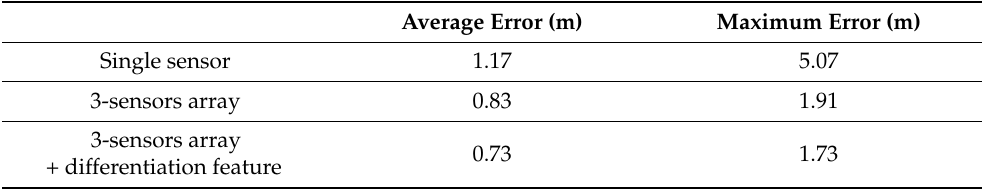
Figure 15. Indoor positioning experiment of sensor array with differentiation features. Table 3. Accuracy comparison of different configurations of RFMC.